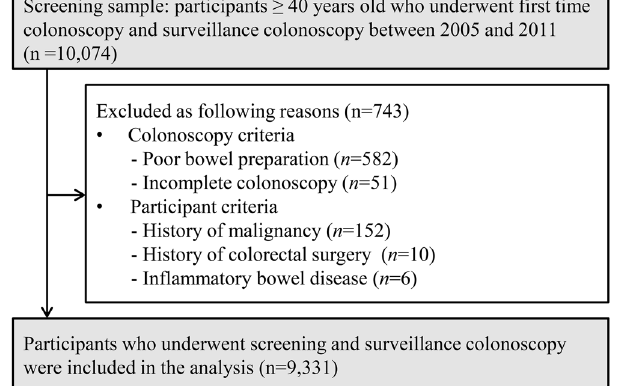
Figure 1. Flow diagram of study